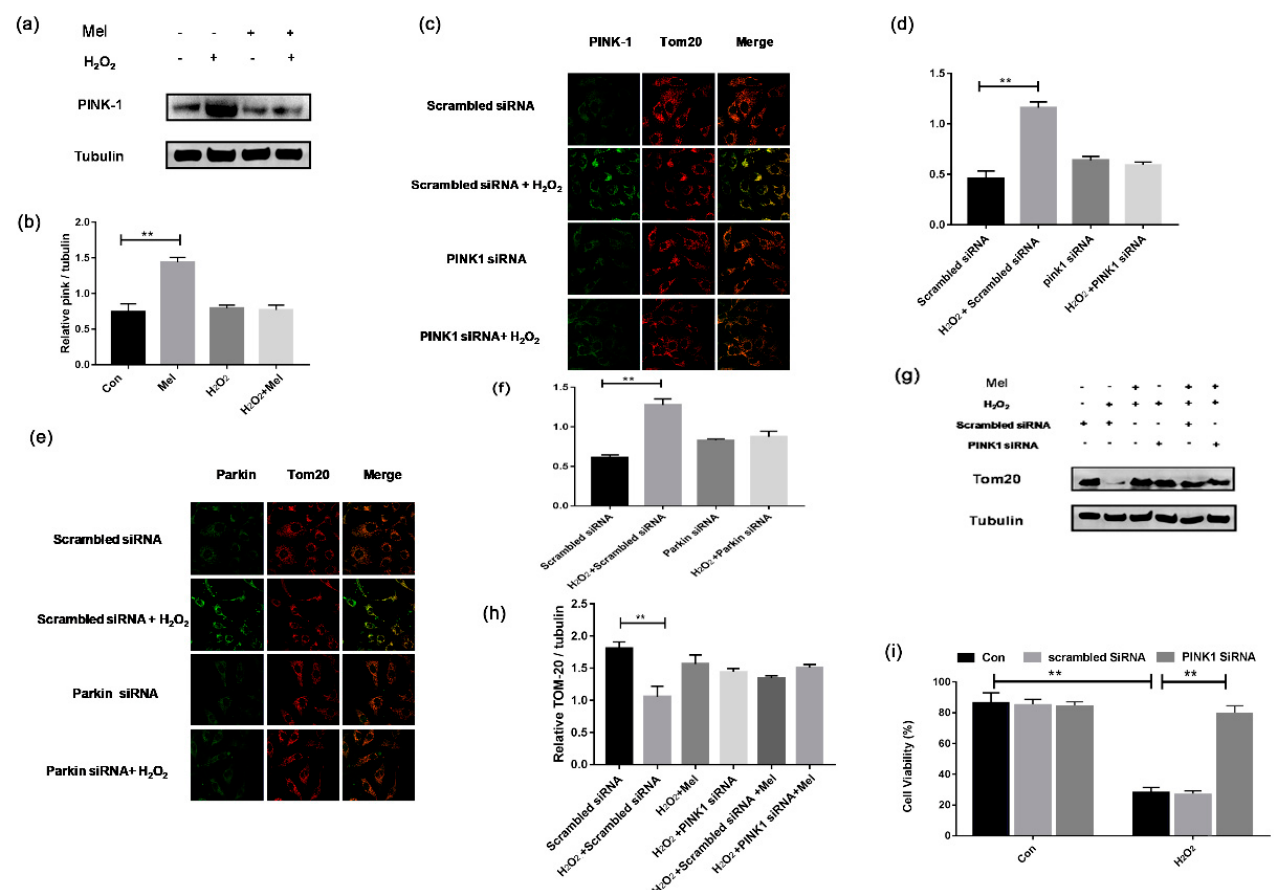
Figure 6. MEL relieved mitophagy and protected GCs from oxidative injury by targeting PINK-Parkin pathway. ( a , b ) Western blot assay of PINK1. α -tubulin was used as an invariant control for equal loading. ( c – f ) GCs were transfected with PINK siRNA or Parkin siRNA for 24 h. Scramble control siRNA was transfected cells were served as control group. After incubating with 200 μ M H 2 O 2 for 1 h, cells were cultured in media containing 10 μ M MEL for another 2 h. Mitochondria were stained by anti-Tom20 (red) and the Parkin or PINK1 was counterstained with anti-Parkin or anti-PINK1 (green). ( g , h ) GCs transfected with PINK1 siRNA or scramble control siRNA for 24 h were exposed to 200 μ M H 2 O 2 for 1 h and treated with 10 μ M MT for another 2 h. α -tubulin was used as an invariant control for equal loading. ( i ) GCs transfected with PINK1 siRNA or scramble control siRNA for 24 h were exposed to 200 μ M H 2 O 2 for 1 h. Cell viability was determined using the CCK-8 assay. Experiments were repeated in triplicate. Data represent mean ± S.E; n = 3. Significances were marked as ** p < 0.01 vs. control group.